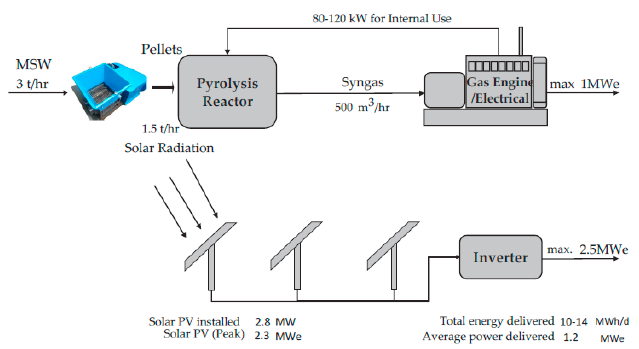
Figure 5. Integration of syngas production and solar PV.